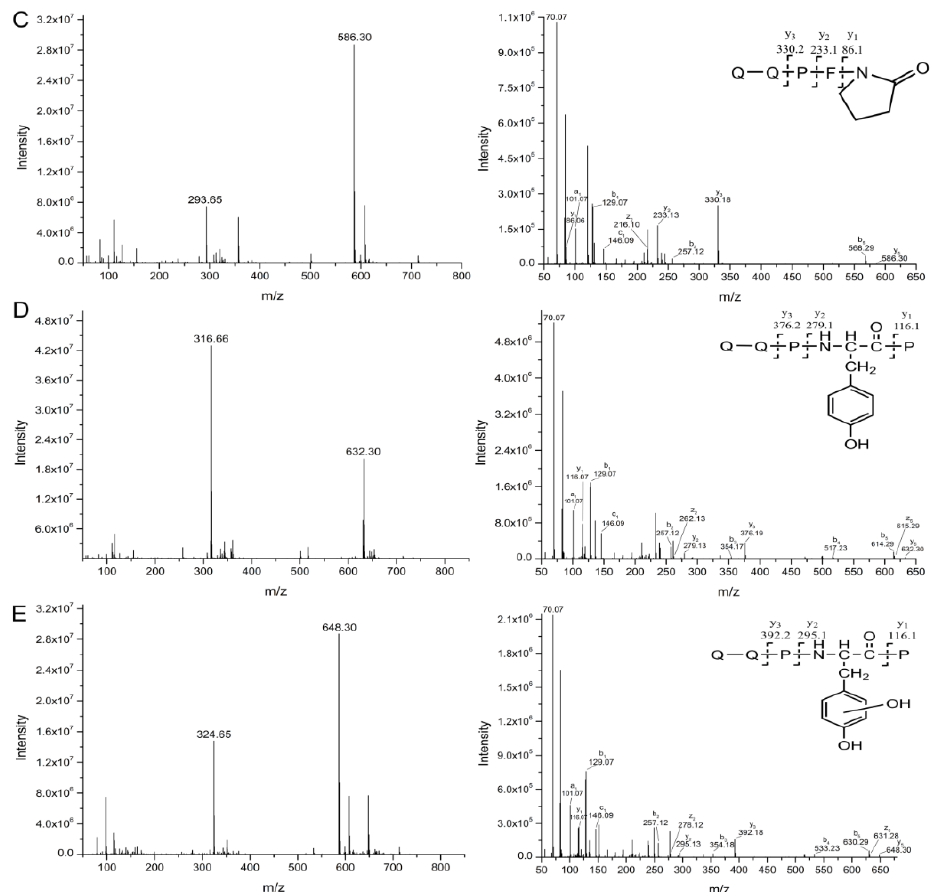
Figure 4. Full-scan mass spectrometry (MS) and representative MS/MS spectra of QQPFP and its products (P1~P4) during plasma treatment, showing evidence for •OH-mediated modification. In each panel, the left spectrum shows the full scan, while the right spectrum shows the fragment ions. The b and y ions originated from preferential cleavage at the N-terminus and C-terminus of specific amino acid residues during collision-induced dissociation, respectively. ( A ) Original peptide (616.3 m / z ); ( B ) product 1 (342.2 m / z ); ( C ) product 2 (586.3 m / z ); ( D ) product 3 (632.3 m / z ); ( E ) product 4 (648.3 m / z ).